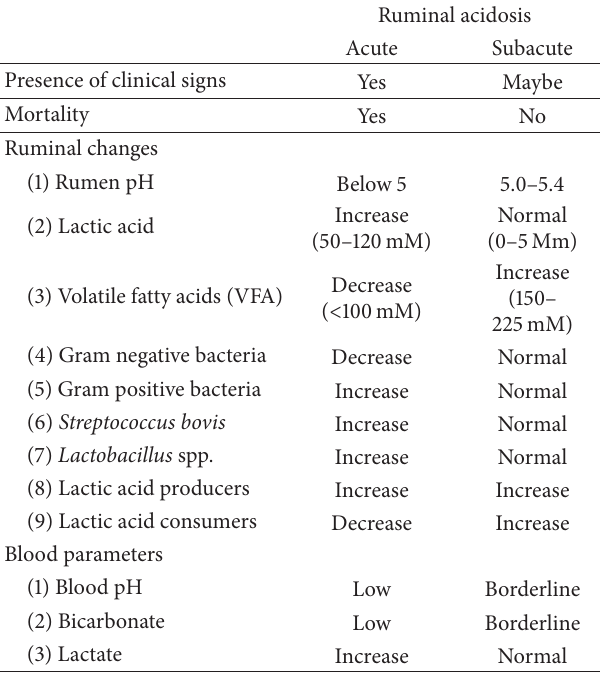
Table 1: Main differences between the two different clinical forms of ruminal acidosis [5].